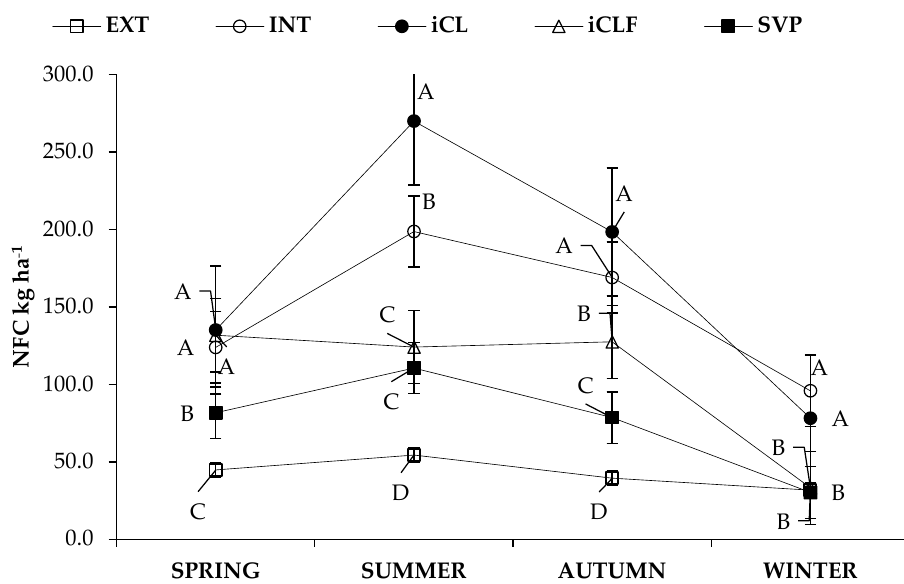
Figure A4. Neutral detergent fibre (NDF) (kg ha − 1 ) during seasons from different livestock production systems (means of two years). Different letters in the same season differ from each other ( p < 0.05) according to the Tukey test. EXT: extensive; INT: intensive; iCL: integrated crop–livestock; iCLF: integrated crop–livestock–forest; iLF: integrated livestock–forest.